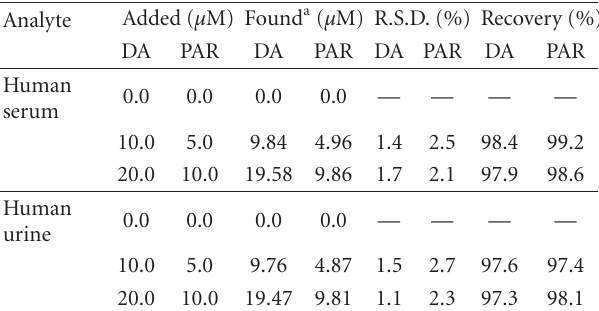
Table 2: Determination of DA and PAR in human serum and human urine with MCNTs/GCE. Analyte